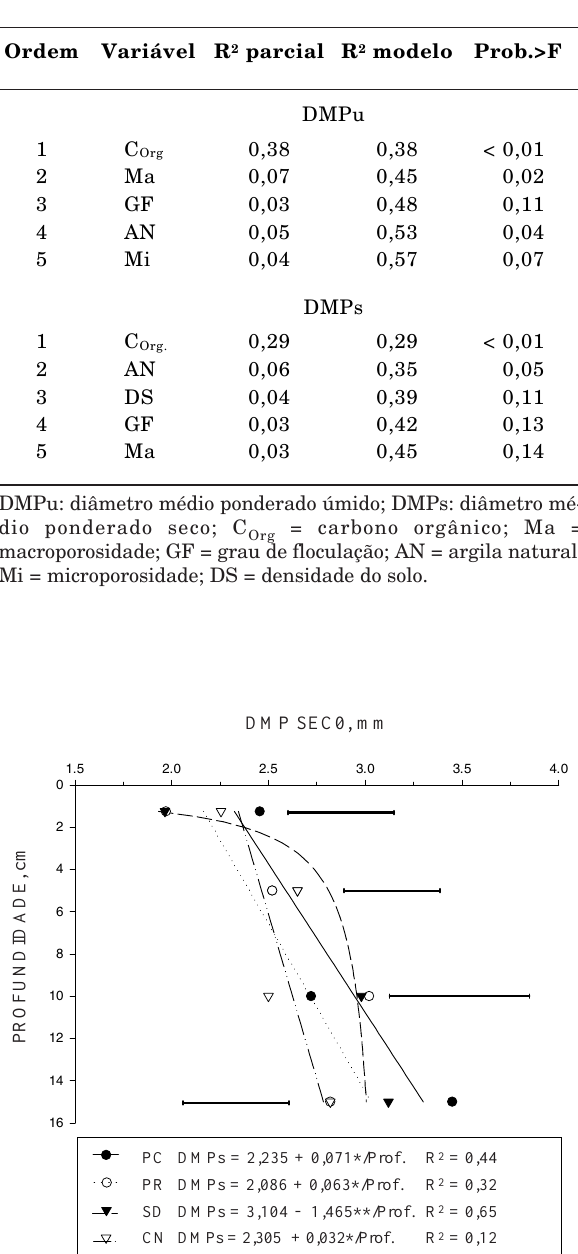
Figura 5. Estabilidade de agregados indicada pelo diâmetro médio ponderado (DMP) obtido por peneiramento seco sob diferentes sistemas de manejo, em diferentes profundidades. Os pontos representam as médias dos tratamentos (n =